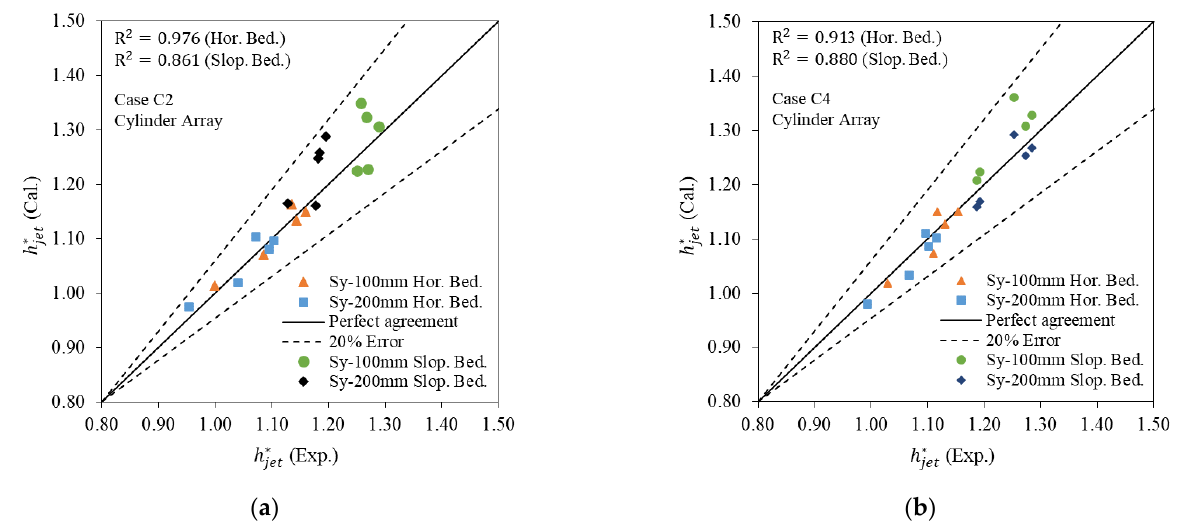
Figure 9. Correlation plots for the experimental dimensionless wall - jet height ( ℎ 𝑗𝑒𝑡∗ ) and that predicted according to Equation (6) ( a ) for the case C2 array and ( b ) for the case C4 array.